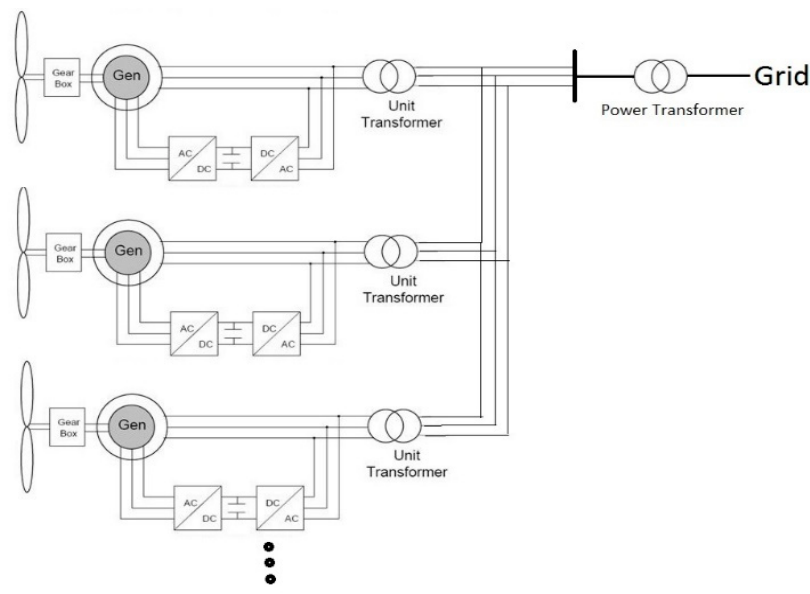
Figure 3. Single-line diagram of a wind farm.